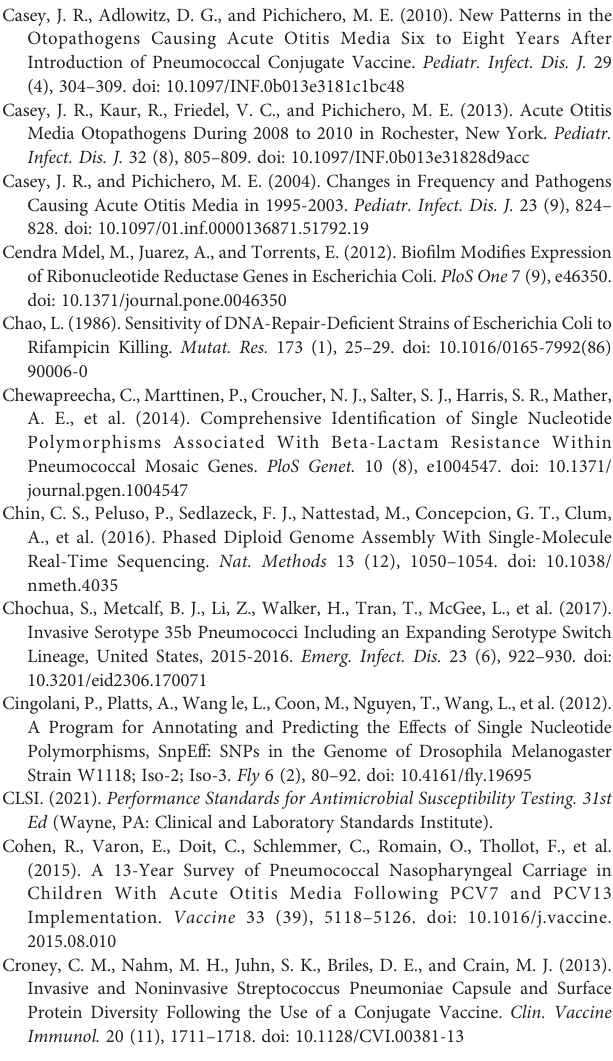
Supplementary Figure 1 | The line graphs of SNPs and indels in the capsule donor and recipient strains when aligned with Mauve to S558, the strain with the capsule switch. The x-axis shows the coordinate on contig 18 or the coordinate on the fi rst 35 kb of contig 2. The y-axis shows the number of indels (top graphs) or SNPs (bottom graphs) in each 1 kb sliding window. The orange lines represent the capsule recipient, S534, and the purple lines represent the capsule donor, S548. Different segments of interest are separated by dashed green lines on contig 18 at 19,600, 30,000, and 34,229 bp and on contig 2 at 3,890, 12,200, and 15,000. The segments are labeled (A – H) on the top graphs. (D, E) are the 35B capsule. Supplementary Figure 2 | Gene presence/absence difference in ST558 associations with time periods and health